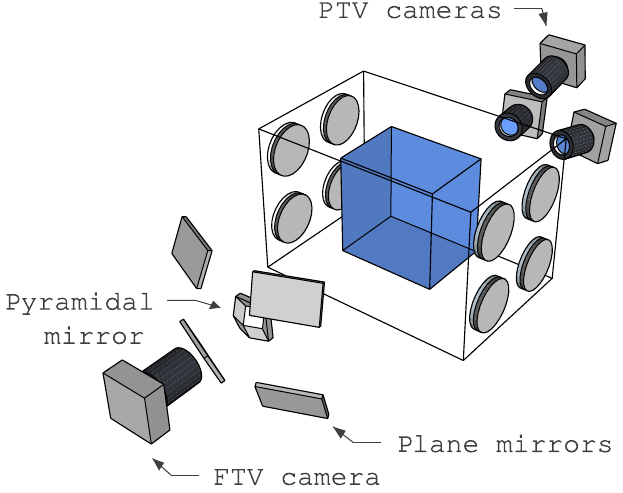
FIG. 15. Schematic representation of the simultaneous fiber- particle tracking system. Four synchronized cameras are em- ployed, three of which for particle tracking velocimetry, while the fourth equipped with an image splitter and a green-cutting-off filter records the motion of the fibers. The image splitter consists of four plate mirrors that project the reflection of the observation volume from different viewpoints on a pyramidal mirror and subsequently onto the